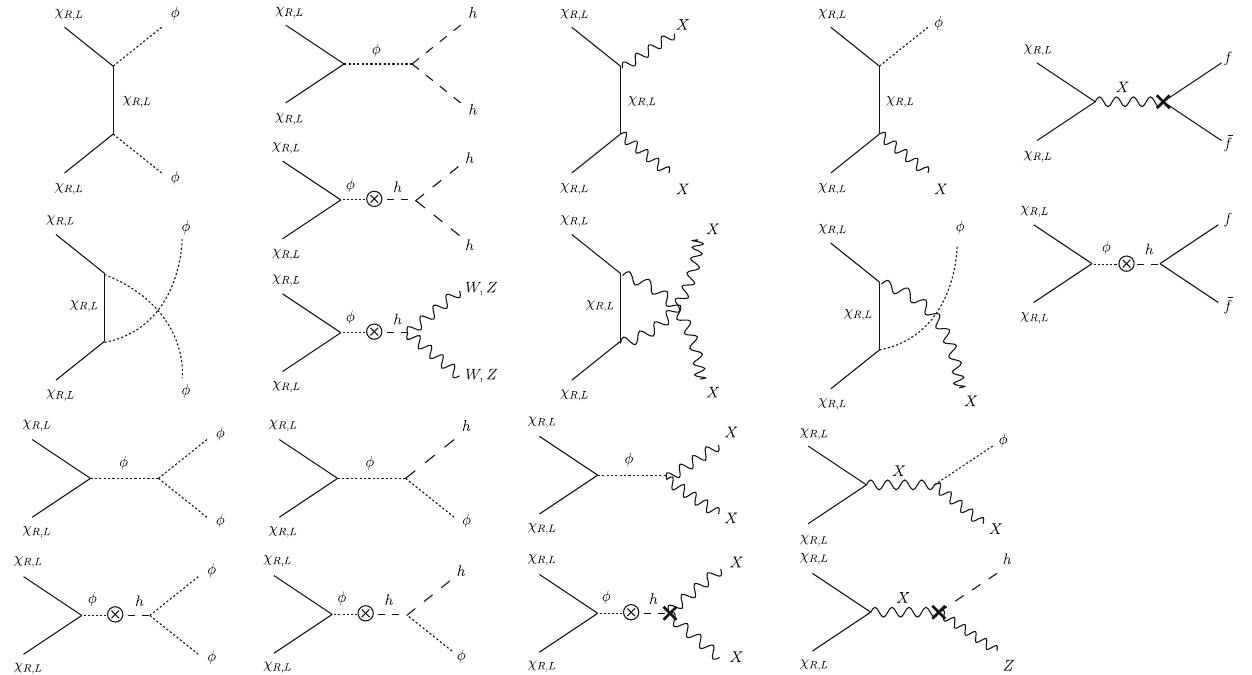
Fig. 8 Possible annihilation processes of dark matters, which is (cid:4) (cid:5) χ χ ; SMs, φ, X μ v (cid:8) . These processes arerepresented denoted by (cid:7) σ L L in the flavor basis. The cross on the right-hand side diagram stands for the kinetic mixing between U ( 1 ) Y and U ( 1 ) X gauge fields. The cross in a circle stands for the mixing between φ and h . “SM” indicates con- tributions from the SM particles except for the Higgs boson, i.e., W Fig. 9 Annihilation processes of the light-handed Majorana fermions into the right-handed ones. This is denoted by (cid:7) σ(χ )v χ ; χ χ L L R R